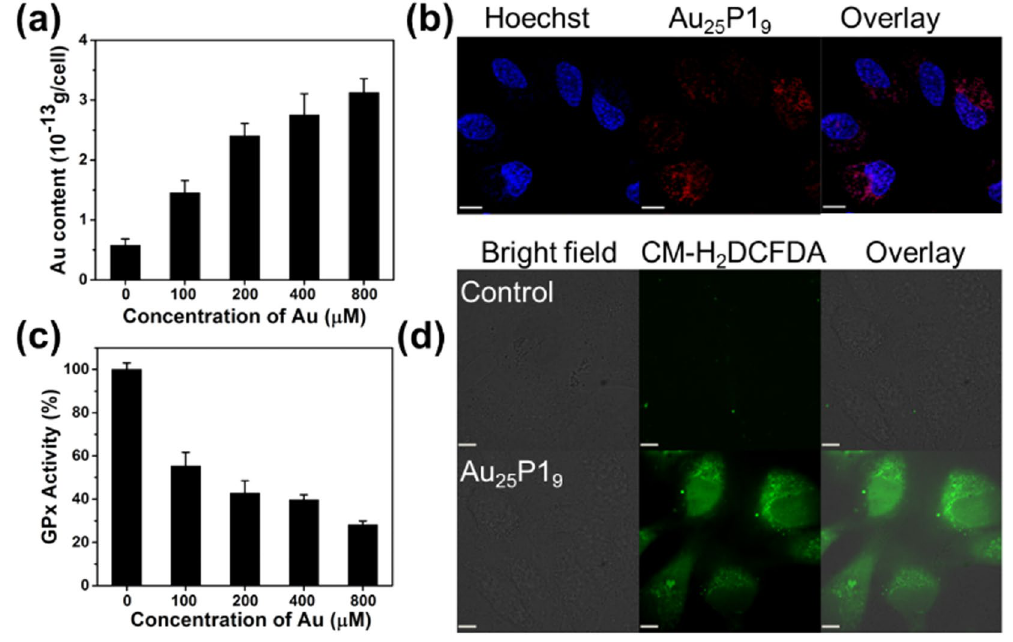
Figure 3. ( a ) Quantification of Au 25 P1 9 uptake by A549 cells ( b ) CLSM images of A549 cells treated with 800 µ M of Au 25 P1 9 for 48 h and the cell nuclei were stained with Hoechst 33342. ( c ) GPx-1 activity suppressed by Au 25 P1 9 in a dose dependent manner in A549 cells. ( d ) CLSM images of cellular ROS level of A549 cells treated with Au 25 P1 9 for 48 h, Scale bar is ~11 µ